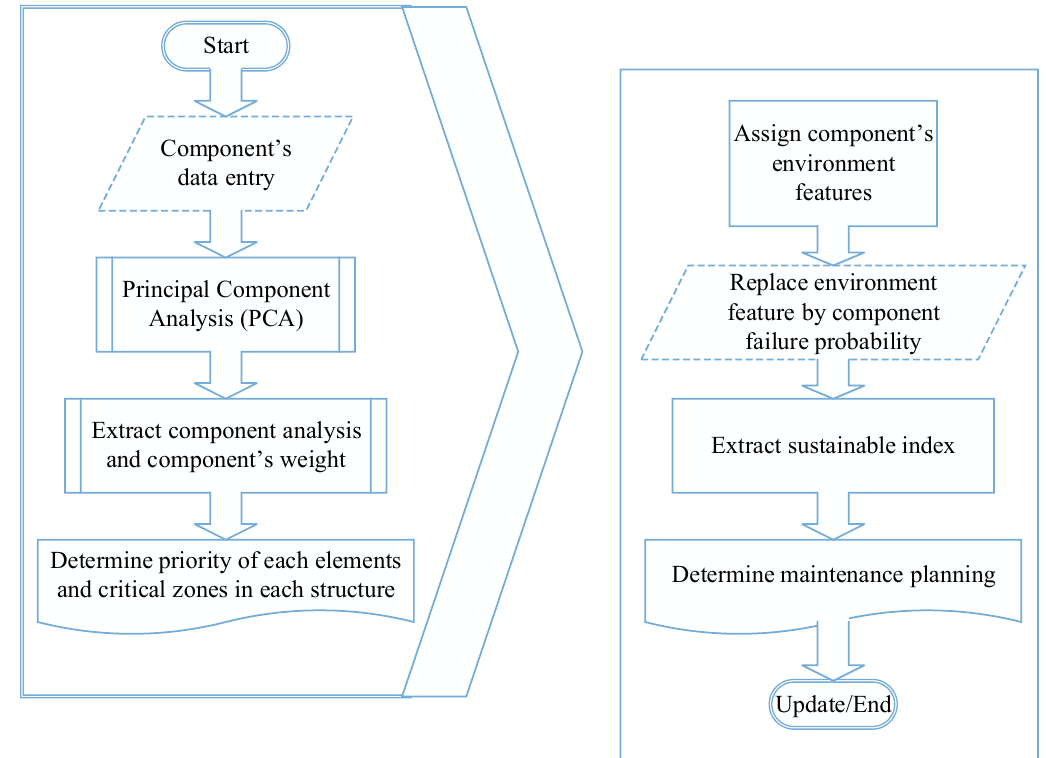
Figure 1. Flow diagram of extracting sustainable